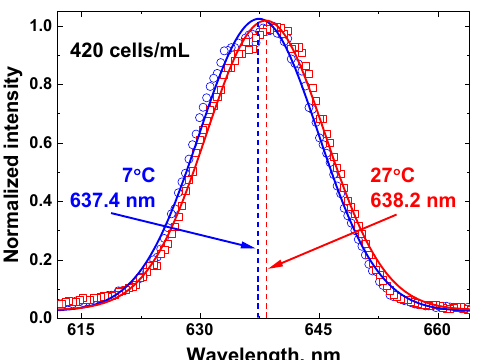
Figure 12. An illustration of the centroid technique for remote water temperature measurements of the water sample with algae concentration 420 cells/ml. The Raman OH band recorded by the LiDAR (blue circles for sample temperature 7 °C and red squares for 27 °C) is fitted with a Gaussian curve (solid lines), and the fitting curve center (represented by dashed lines) is a temperature-dependent metric of the centroid technique.